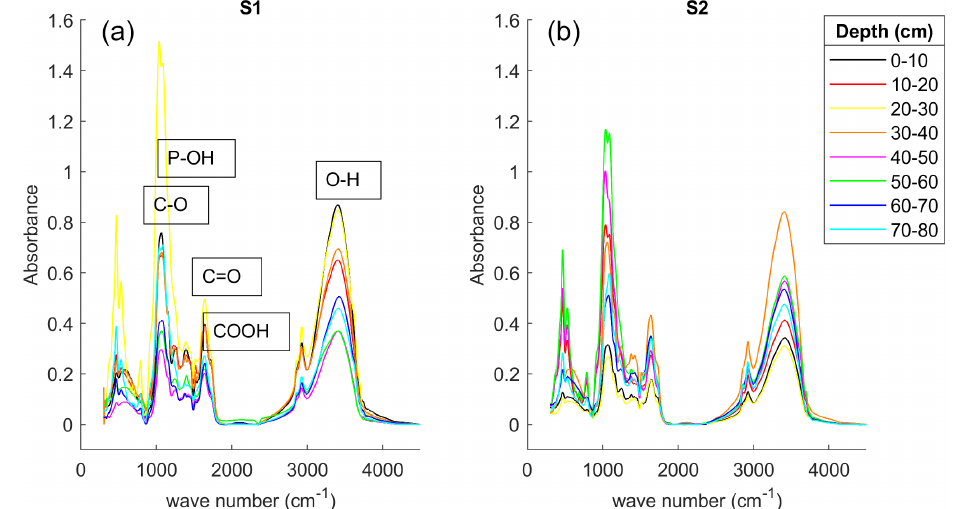
Figure 11. Fourier transform infrared (FTIR) spectroscopy of the freeze-core samples collected at S1 (a) and S2 (b) . Each sample was extracted from the 10cm segments. The lines represent the depth at every 10cm between 0 and 80cm below the ground surface. The relevant peaks show the absorbance intensity; the interpretation is based on Artz et al. (2008), Arai and Sparks (2001), and Parikh and Chorover